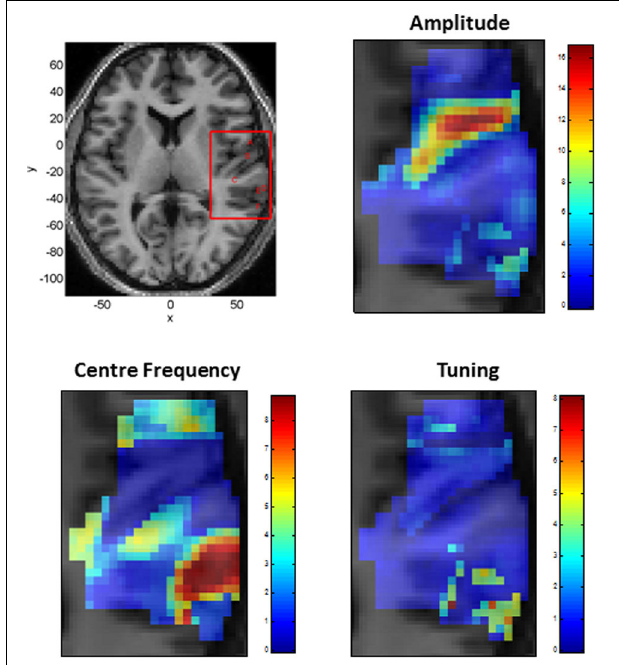
FIGURE 5 | Tonotopic Mapping with Gaussian neural response functions. Top Left: Axial slice of structural image at z = 6 with bounding box showing region displayed on other three panels (x, y, and z denote MNI coordinates in mm). The labeling (A to F) refers to plots in Figures 6 , 8 . Top Right: Amplitude β (arbitrary units), Bottom Left: Center Frequency μ (kHz). Bottom Right: Tuning, W (ratio of Center Frequency to